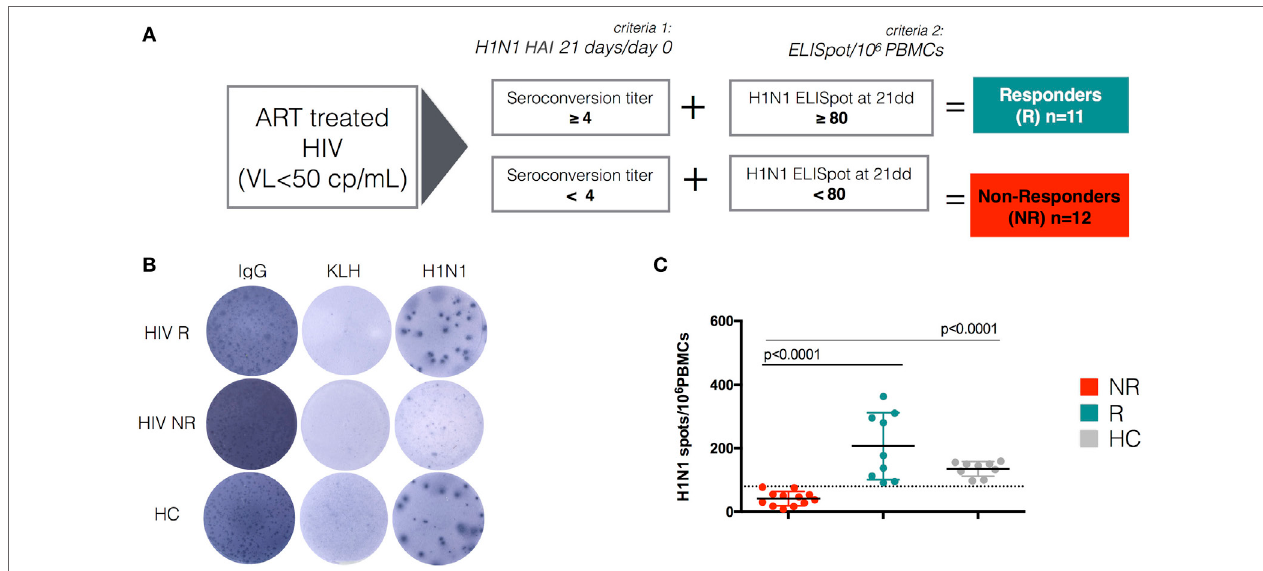
FigUre 3 | H1N1 response after trivalent inactivated influenza in HIV and perturbation of the memory compartment among non-responders. (a) The flow chart describes the criteria of selection used to define responders and non-responders to trivalent-inactivated influenza vaccination (TIV) among HIV-infected children. As a first criteria of selection, all patients were selected according to the fold increase of H1N1 hemagglutination inhibition (HAI) titer. Patients responding or not responding to the first selection criteria were further selected according to H1N1 ELISpot response. Selected healthy donors responded to the vaccination and met both criteria of selection. Representative ELISpot assay (B) and scatter dot plot (c) show ELISpot data for